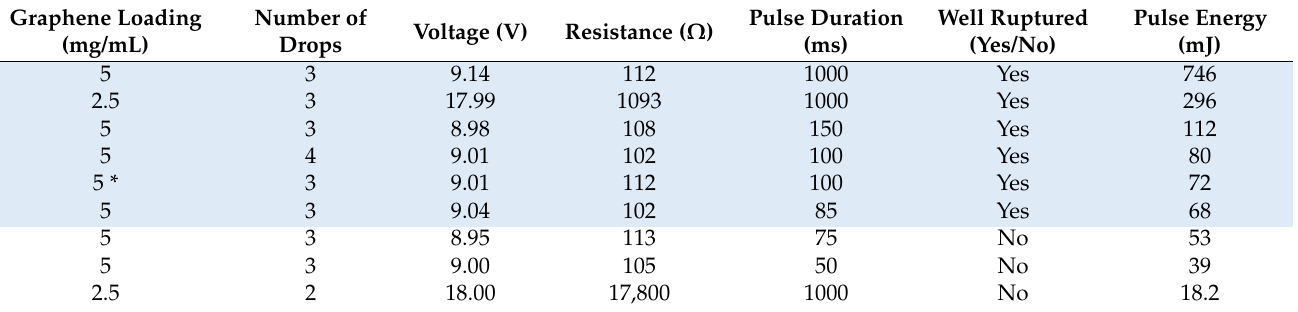
Table 1. Pulse energy data and activation status as a function of graphene loading, number of drops, pulse duration, applied voltage, and filament